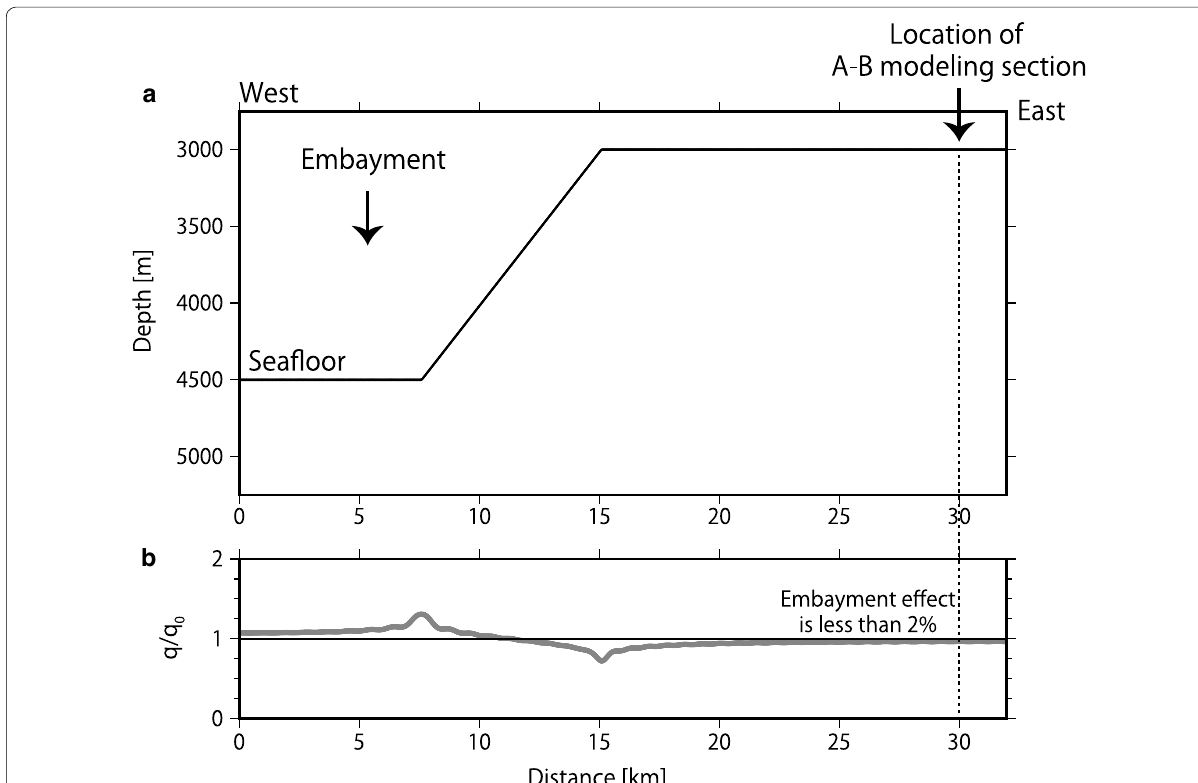
Fig. 10 Effect of a large embayment southwest of the A–B section on surface heat flow. a Simplified bathymetry orthogonal to the A–B section. b Plot of q / q 0 ratio, where q 0 is the heat flow originating from the deep-seated heat flux, and q is the estimated heat flow at the seafloor from the deep-seated heat flux. A ratio less than 1 indicates that the shallow subseafloor is subject to defocusing induced by the topography, whereas a ratio larger than 1 indicates that the shallow subseafloor is subject to focusing induced by the